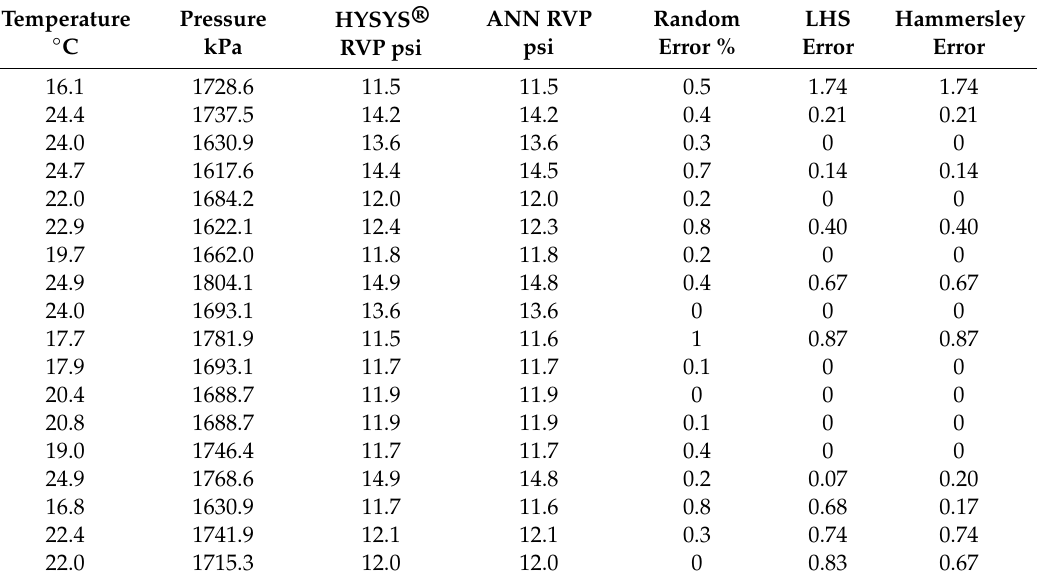
Table 2. Results obtained from di ff erent sampling techniques.